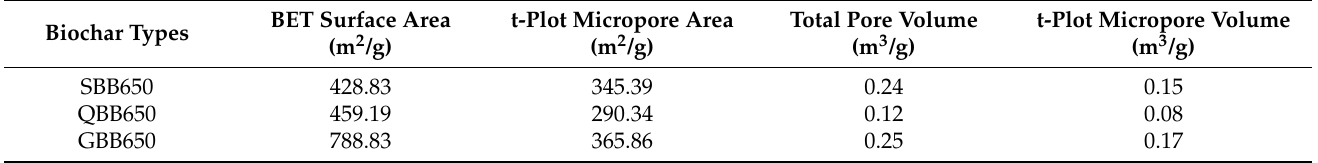
Table 3. Specific surface area and pore volume of three types of biochar prepared at 650 ◦ C.